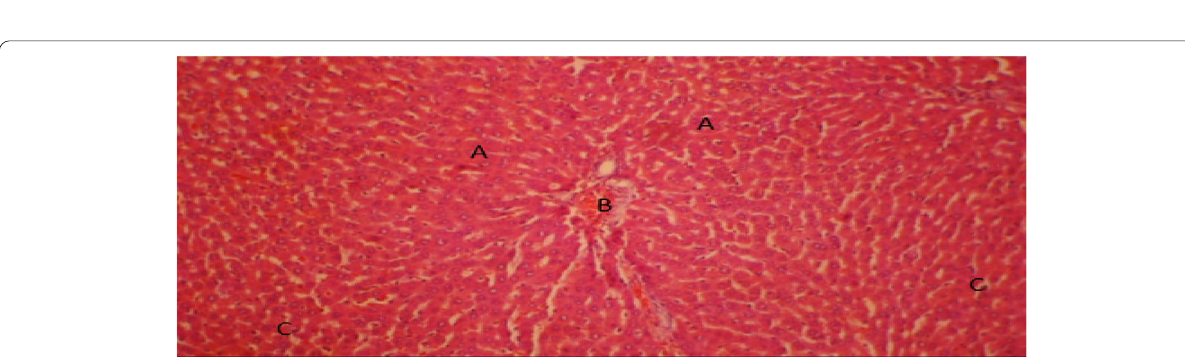
Fig. 5 Liver section of rat given SA for 14 days followed by 100mg/kg leaf extract for 14 days (Group 3) showing: A , normal hepatocytes, B ,